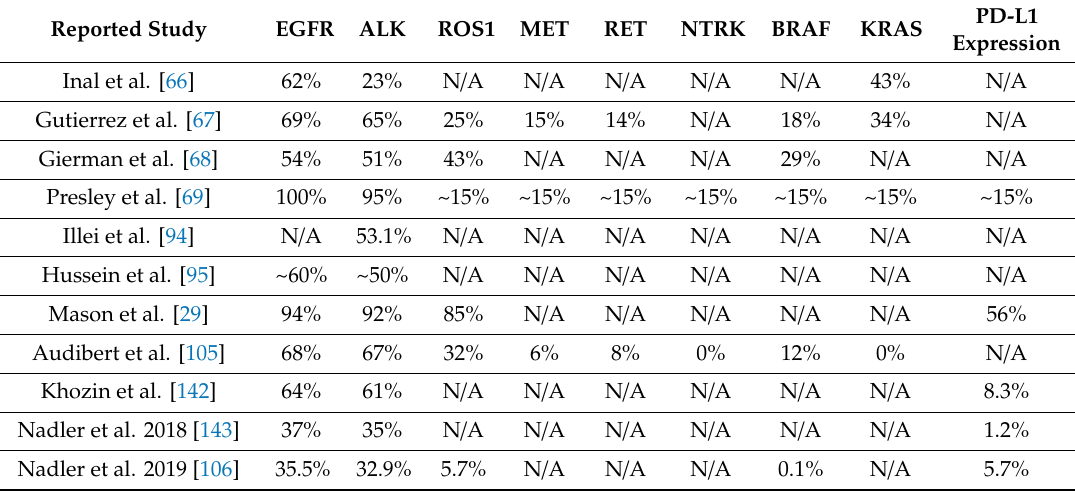
Reported testing rates of clinically actionable and clinically relevant oncogenes in community